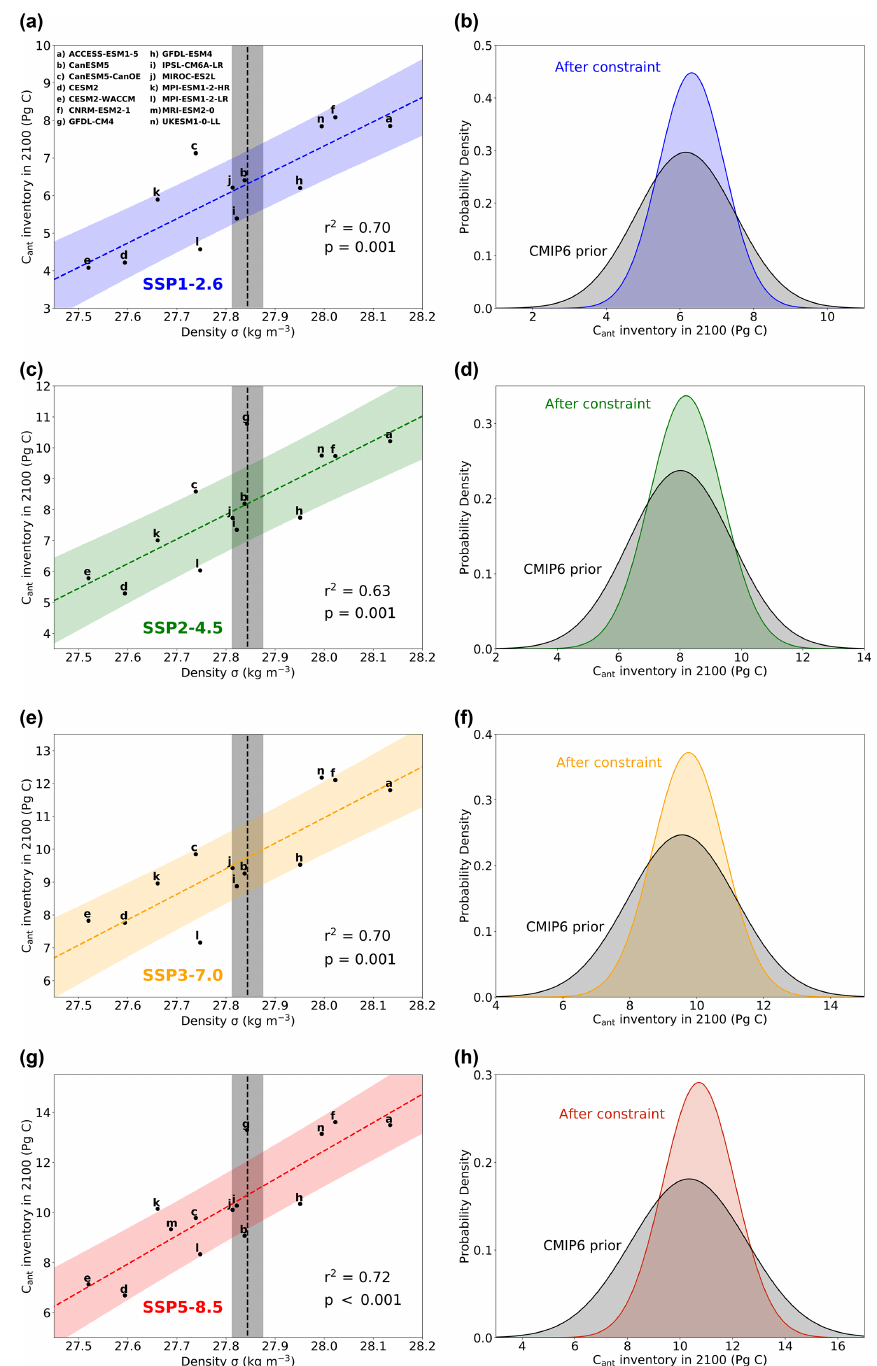
Figure 2. Emergent constraint on Arctic Ocean C ant inventory in 2100. Maximum Arctic Ocean sea surface density (95th percentile) and Arctic Ocean C ant inventory in 2100 for 12–14 ESMs for (a) SSP1-2.6 (blue), (c) SSP2-4.5 (green), (e) SSP3-7.0 (orange), and (g) SSP5- 8.5 (red). The ordinary least-squares regressions (dashed lines) and the ± 1 σ prediction intervals (shaded area) are shown for each SSP. Probability density functions before and after applying the emergent constraint for (b) SSP1-2.6, (d) SSP2-4.5, (f) SSP3-7.0, and (h) SSP5- 8.5.